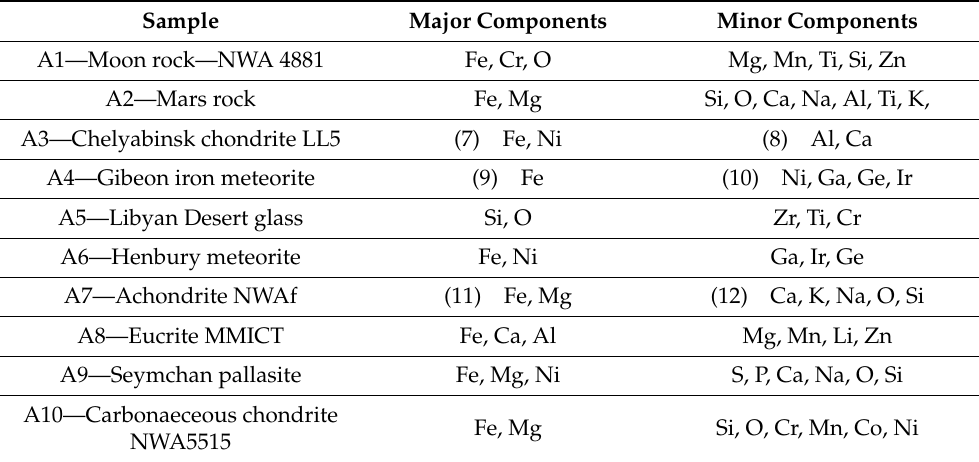
Table 2. Details of the elemental composition of the samples as inferred from the literature [9,28]. Sample Major